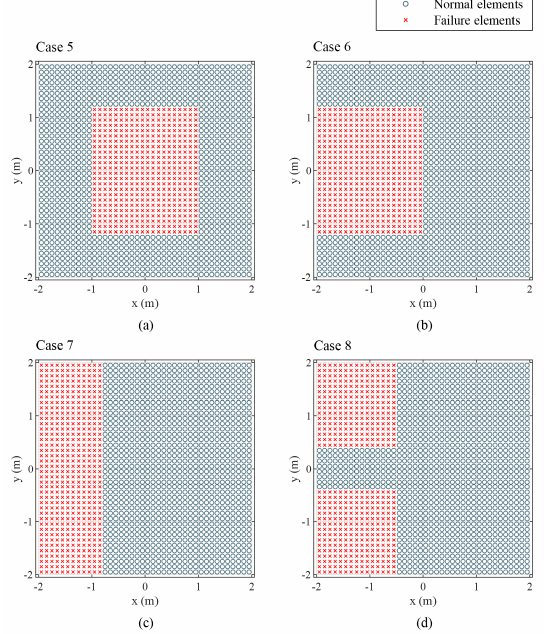
Figure 9. Failure diagrams of the phased-array antenna in different distribution conditions: ( a ) center, ( b ) marginal center, ( c ) uniform edge, ( d ) edge ends.